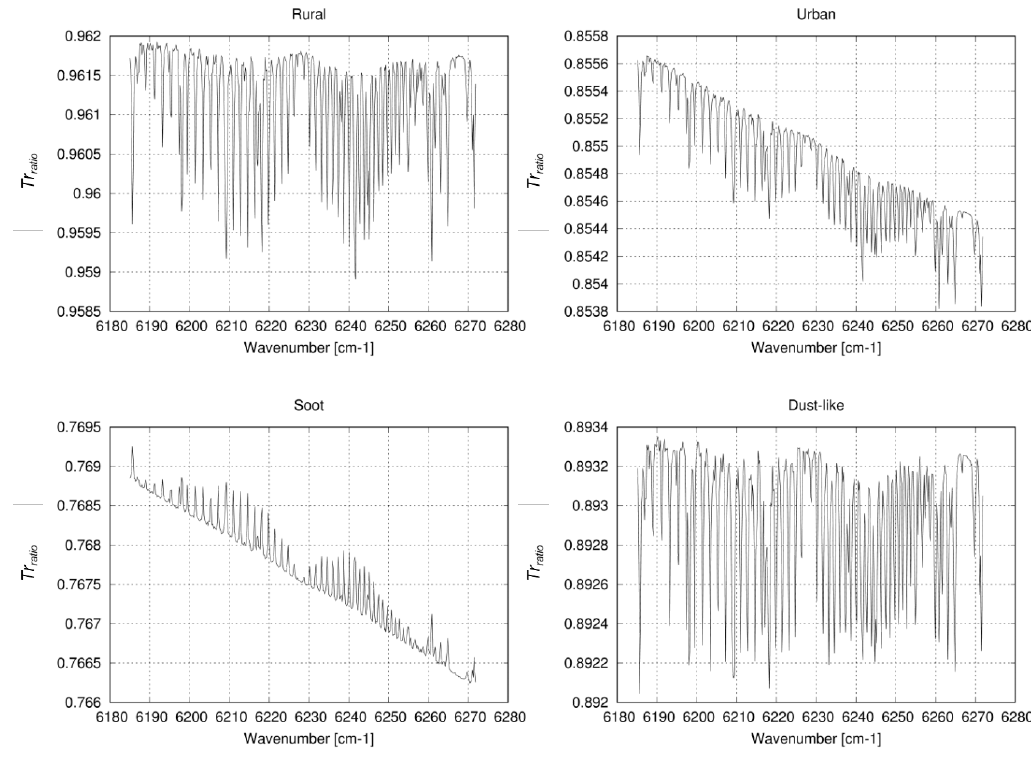
Figure 15. Tr ratio for Rural, Urban, Soot, and Dust-like with AOT of 0.5 at 0.55 µ m for the surface albedo of 0.2, independent of wavelength.